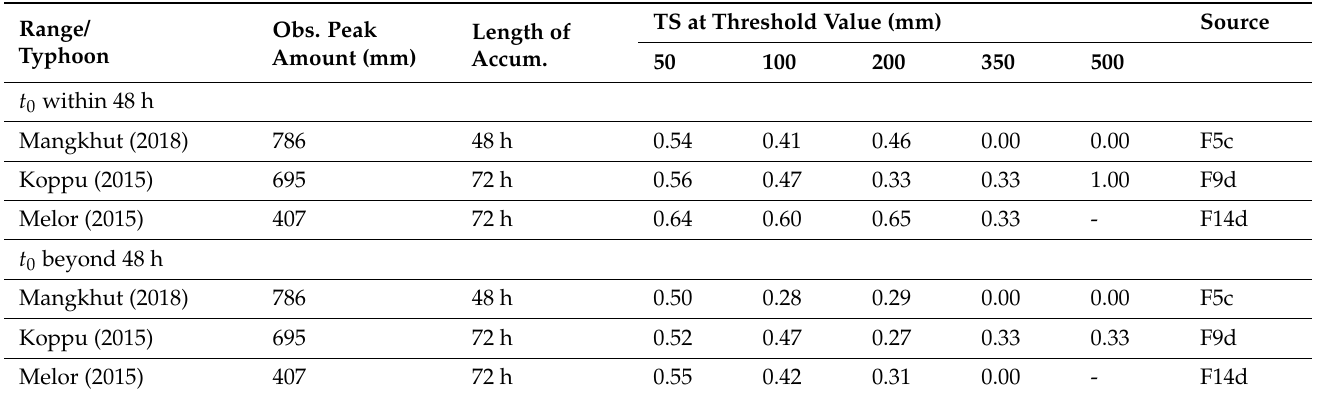
Table 4. As in Table 3, but summarizing the best TSs of QPFs over accumulation periods of 48 or 72 h for entire typhoon events in the Philippines. Results are grouped into runs with a t 0 within ( ≤ ) 48 h prior to the starting time of accumulation (i.e., first 24 h of target period within 72 h, top) and those beyond (>) 48 h (bottom),